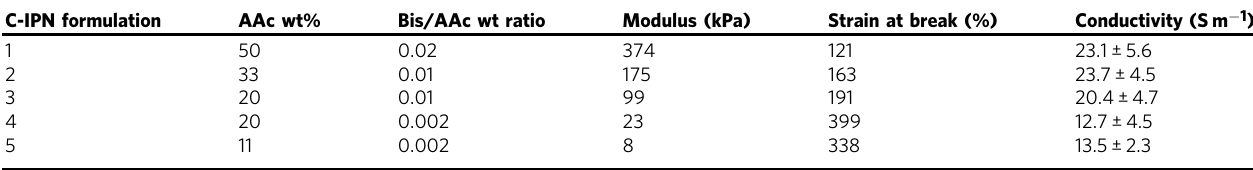
Table 1 Different formulations of C-IPN and their corresponding electronic and mechanical properties C-IPN formulation